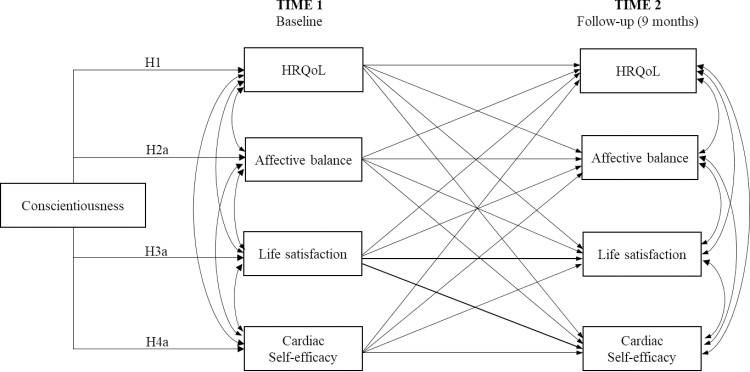
The posited model.